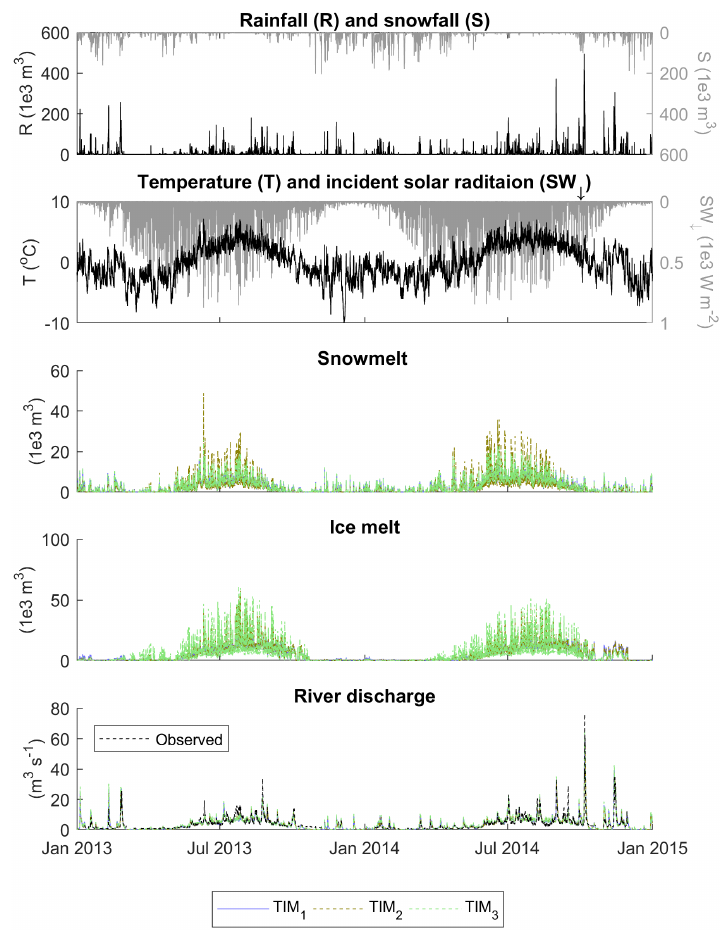
Figure D1. Time series of driving precipitation, temperature and incident solar radiation data and simulated snowmelt, ice melt and river discharge using the TIM 1 , TIM 2 and TIM 3 melt model struc- tures in conjunction with the simplest ROR 1 run-off-routing struc- ture. Note that the proportion of rainfall and snowfall is an output from the GHM, which is approximately equal across the different configurations. Ice melt includes melt of bare ice and